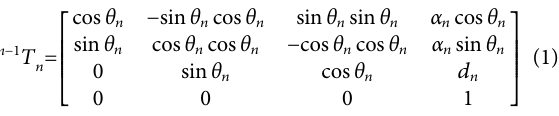
FIGURE 5 Five degrees of freedom